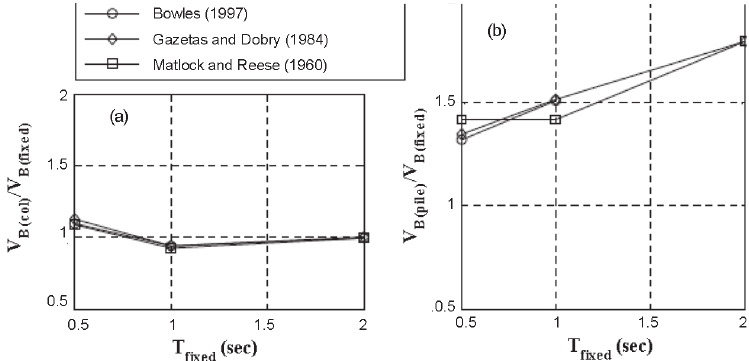
Fig. 6. Comparison responses of three different approaches to determine k h for very soft soil, L/d = 60 and constant soil profile: a) normalised column shear; b) normalised pile head